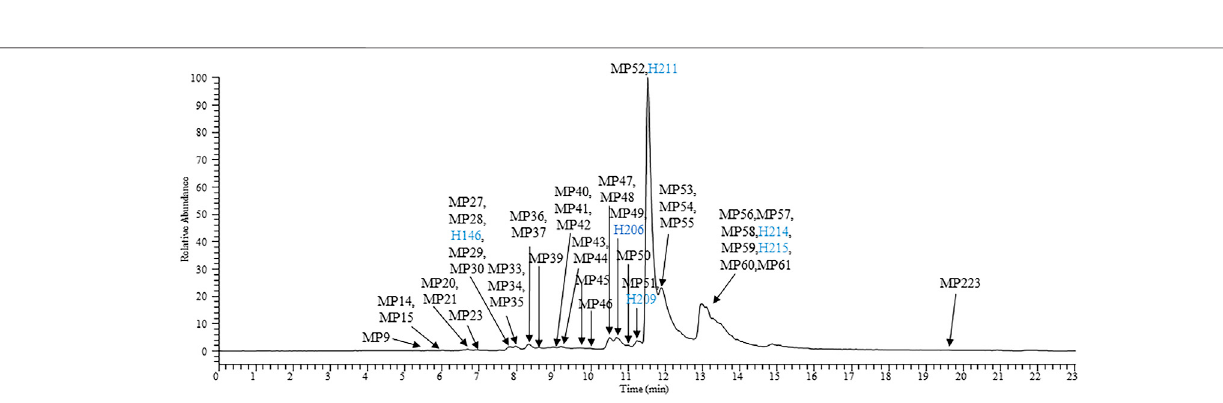
Frontiers in Pharmacology |